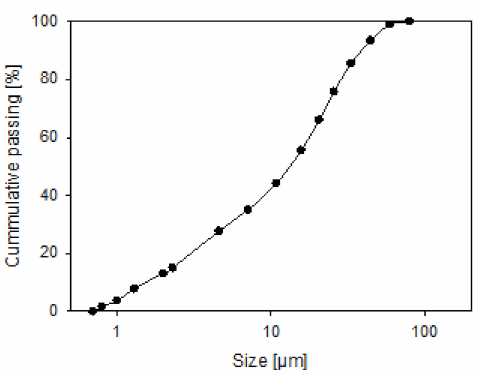
Figure 2. Fourier transform infrared spectroscopy (FTIR) spectrum for kaolin powder.